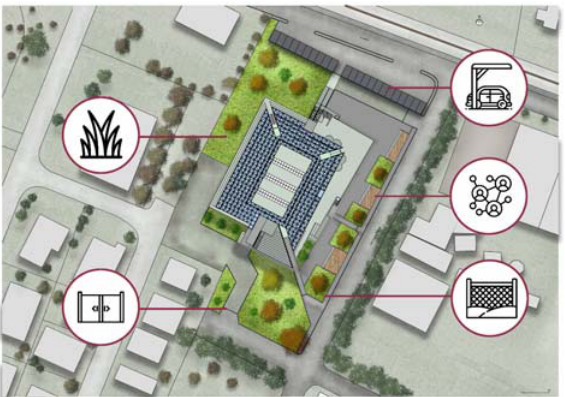
Figure 8 . The results of thermal scanning.